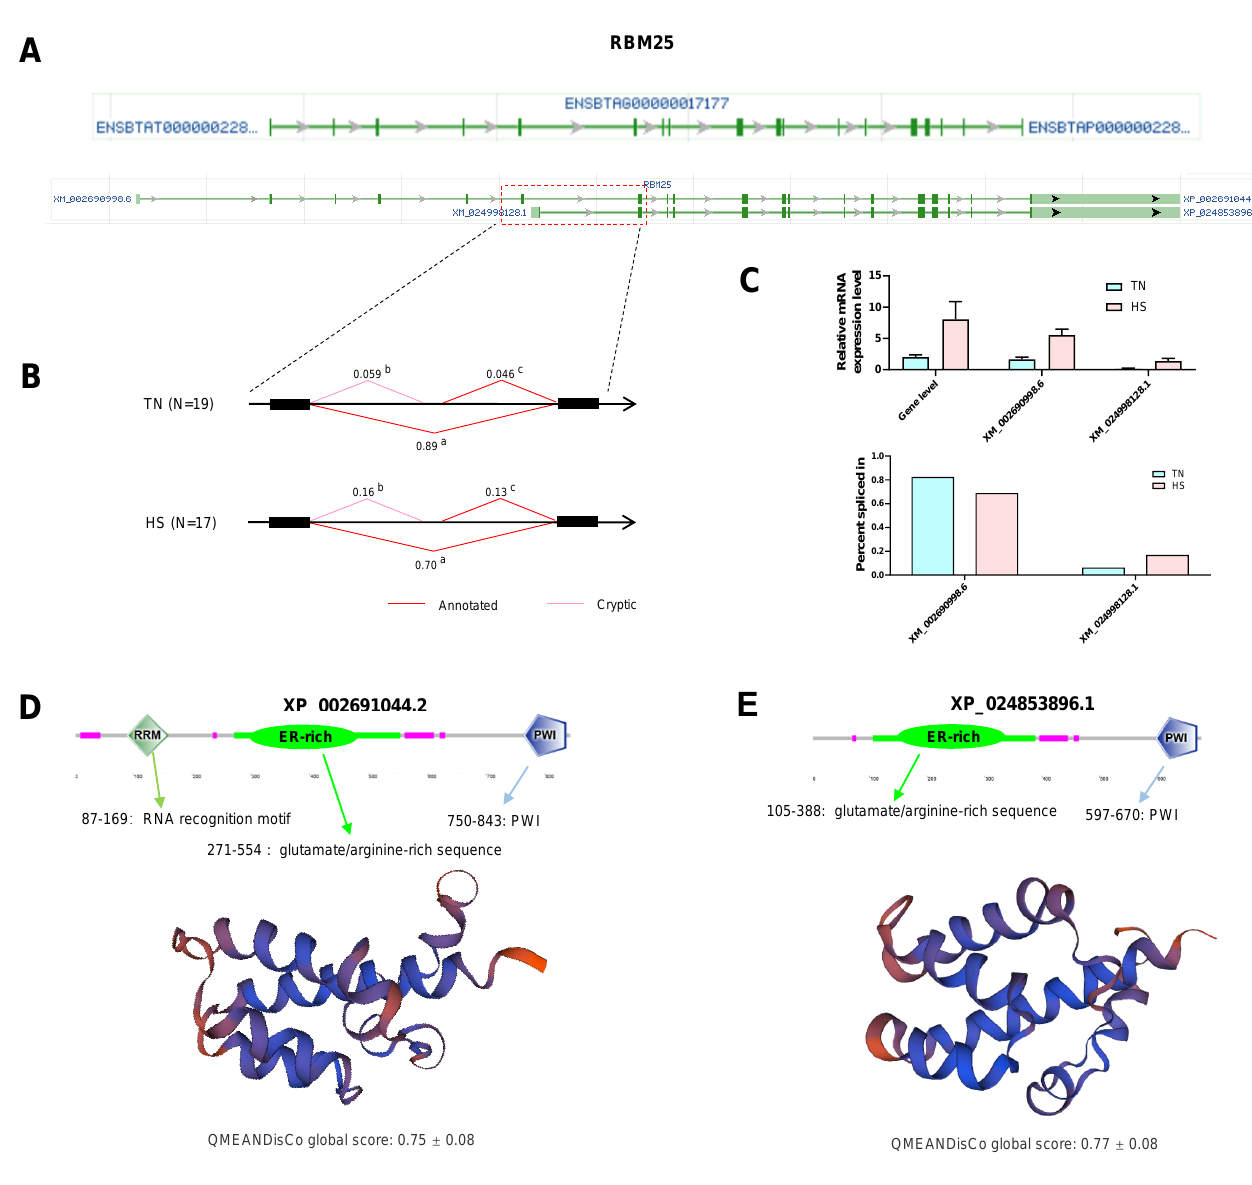
Figure 7. Alternative splicing events in the RBM25 gene. ( A ) Genomic regions and annotated transcript isoforms of the RBM25 gene. ( B ) Differentially alternative spliced events between thermal neutrality (TN) and heat stress (HS) groups. ( C ) Expression verification of identified events through real-time quantitative PCR (qRT-PCR). ( D ) Functional domains and three-dimensional structures of XP_002691044.2. ( E ) Functional domains and three-dimensional structures of XP_024853896.1. The QMEANDisCo global score is the average per-residue score estimated from the